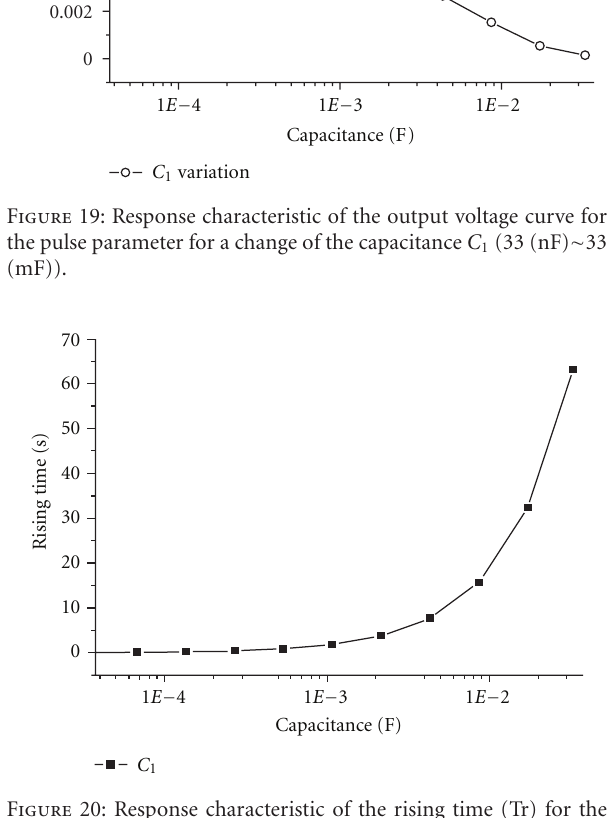
Figure 20: Response characteristic of the rising time (Tr) for the pulse parameter for a change of the capacitance of C 1 (33 (nF) ∼ 33